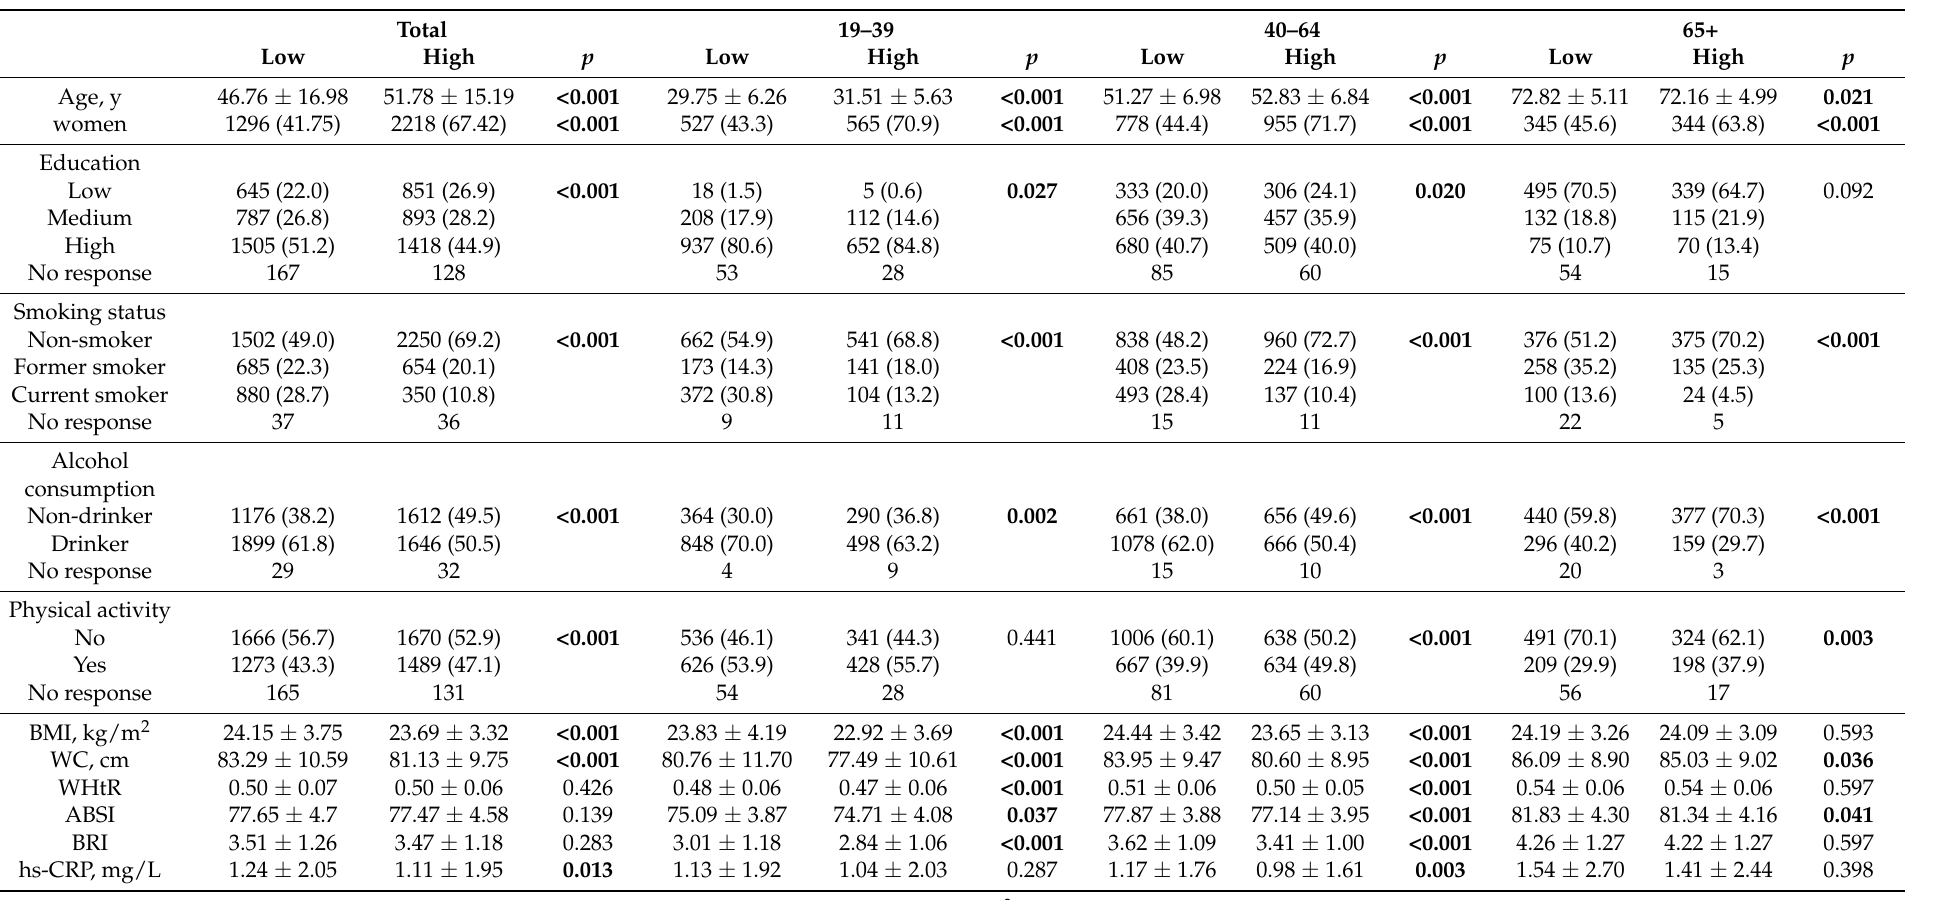
Table 2. Participants’ sociodemographic and clinical characteristics according to the level of serum